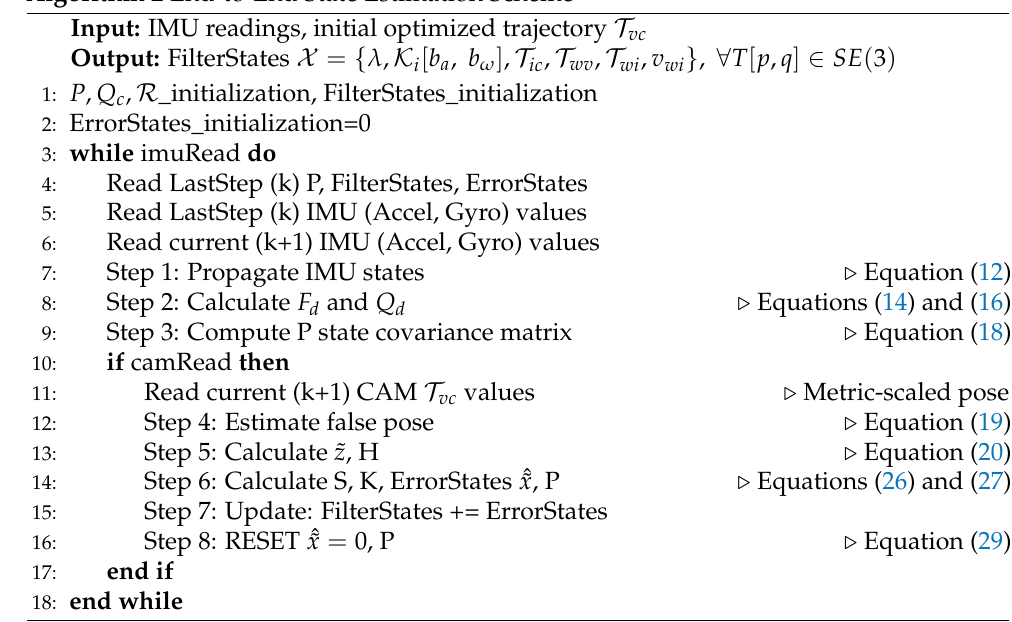
Figure 3. Overview of our proposed entire system architecture. Algorithm 2 End-to-End State Estimation